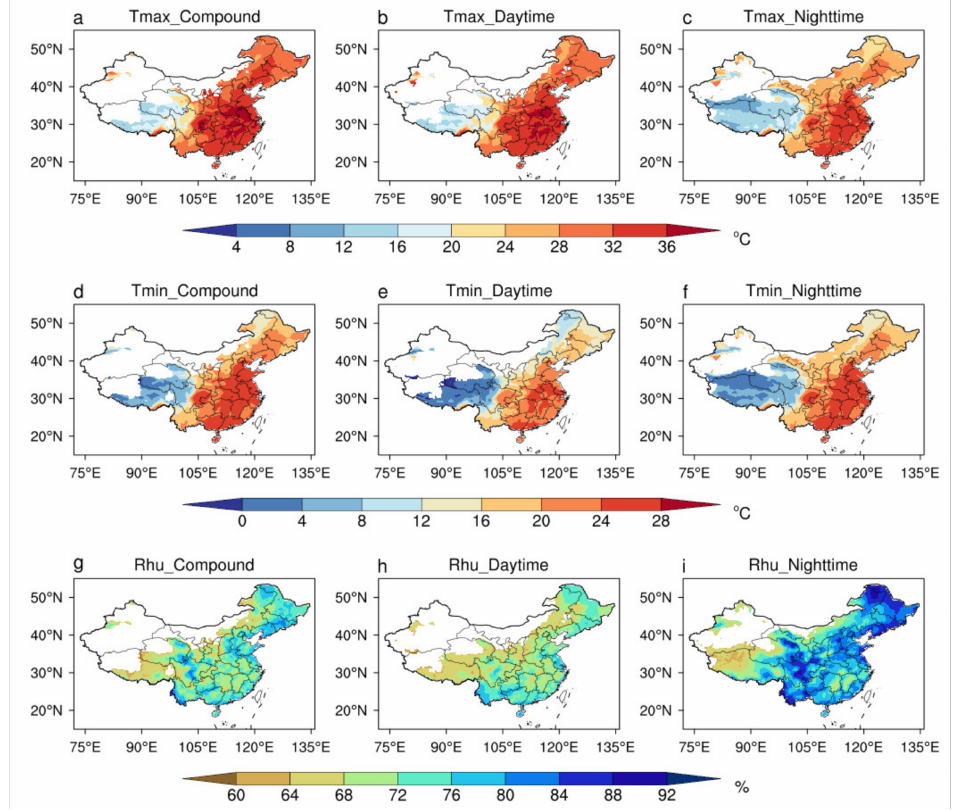
Figure 3. Spatial patterns of the average ( a – c ) maximum temperature ( T max ), ( d – f ) minimum tem- perature ( T min ), ( g – i ) relative humidity ( Rhu ) during compound, daytime and nighttime HW days from 1961 to